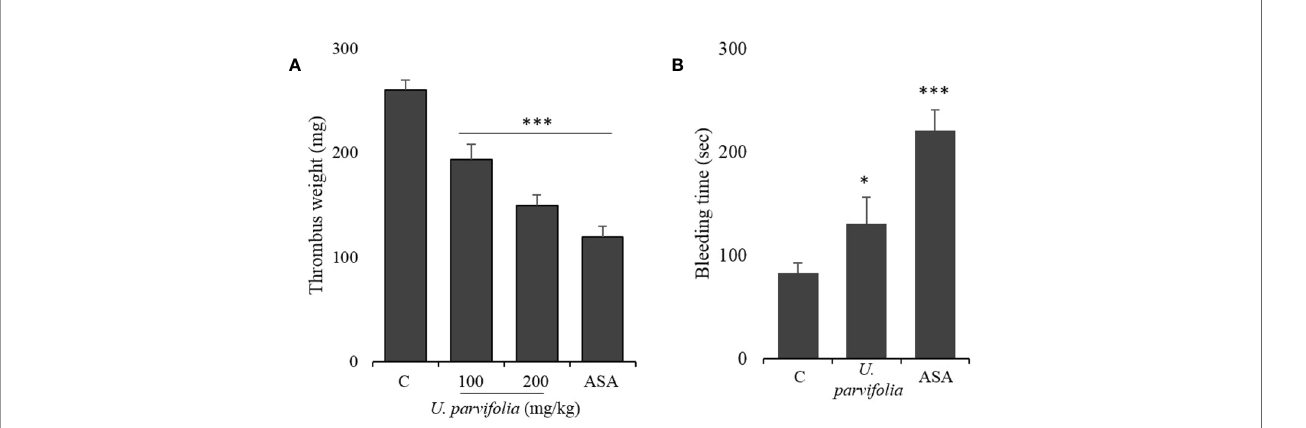
FIGURE 6 | U. parvifolia inhibits thrombus formation and modulates hemostasis. (A) Evaluation of in vivo anti-thrombotic activity and determination of thrombus weight in AV shunt model of rats that were orally administered with saline, U. parvifolia extract (100 – 200 mg/kg), or ASA (50 mg/kg). (B) Results of tail bleeding assay for homeostasis measurement in mice administered with U. parvifolia extract (200 mg/kg), ASA (50 mg/kg), or saline (n = 5 in each group). Graph shows mean ± SD values from at least fi ve independent experiments performed. * p < 0.05; *** p < 0.001 versus